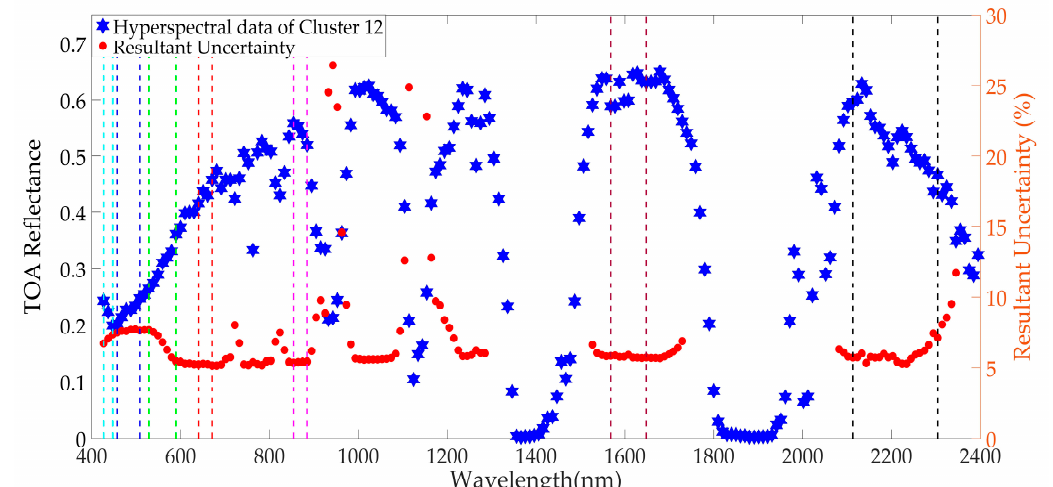
Figure A9. Estimated representative hyperspectral profile of Cluster 11 and its resultant uncertainty.